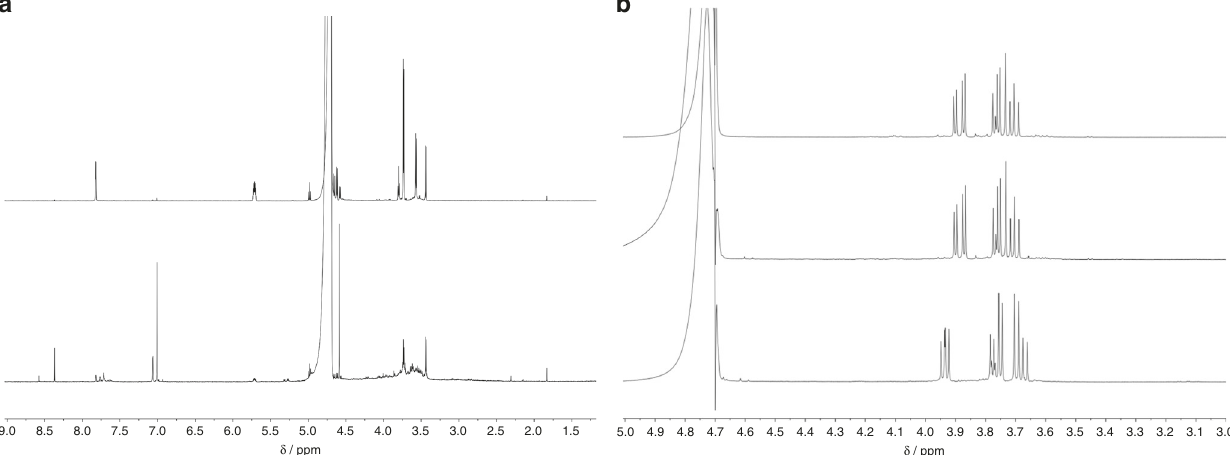
Fig. 5 Protection of 5 at high pH and modi fi ed Strecker synthesis. 1 H NMR Spectra showing the protection of glycolaldehyde 5 by bisul fi te in the presence of NH 3 and the Knoevenagel – Bucherer modi fi ed Strecker synthesis of serine aminonitrile. a Upper spectrum — 5 in H 2 O/D 2 O with NH 3 at pH 9.2 after 10 min; lower spectrum — as upper spectrum after 7 days at room temperature. b Upper spectrum — 5 and Na 2 SO 3 in H 2 O/D 2 O with NH 3 at pH 9.2 after 10 min; centre spectrum — as upper spectrum after 7 days; lower — as centre spectrum with KCN added after 2 h, pH